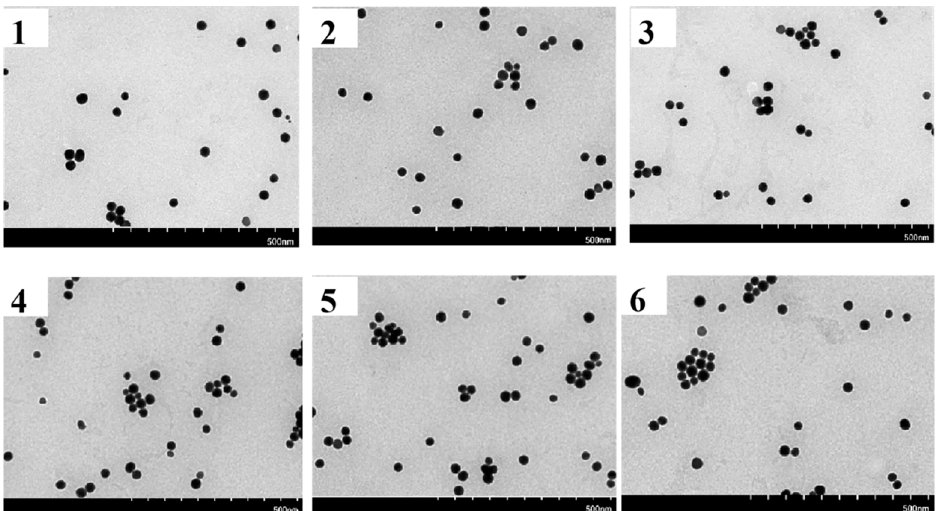
Figure 6. ( a ) Image of the gold nanoparticle solution; ( b ) Tindal effect diagram. After being left alone for six months, the state of the solution was observed to be unchanged, indicating that the stability was good. After the preparation of gold nanopar- ticles, with the passage of time, the characterization of transmission electron microscope was carried out every month, as shown in Figure 7, to further observe the dispersion phe- nomenon of gold nanoparticles and whether there was agglomeration. The results ob- tained according to Figure 7 show that the gold nanoparticles have good dispersibility and do not show a large amount of agglomeration after being placed for 6 months.